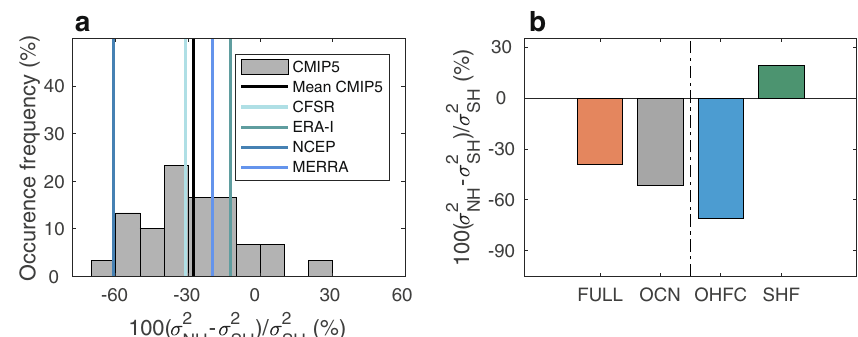
Fig. 1 Hemispheric difference in the Hadley cell variability and the role of ocean coupling. a The occurrence frequency (in percentage) of the difference in the variance of Ψ max in the NH ( σ 2 ) and SH ( σ 2 ) (in percentage) over the 1979 – 2017 period in CMIP5 models (gray bars). NH SH Black and blue vertical lines show the difference in the variance between the hemispheres in CMIP5 mean and reanalyses, respectively. b The difference in the variance of the NH and SH Ψ max in the FULL run (red bar). The relative contribution to the difference in the variance from ocean coupling (gray bar, OCN) and from decomposing the ocean coupling to dynamic coupling (OHFC, blue bar) and thermodynamic coupling (SHF, green to σ 2 . Almost all CMIP5 models (27 out of 30, gray bars in Fig. 1a) SH show that σ 2 is smaller than σ 2 , with a multi-model mean value NH SH of − 28% (vertical black line). Similarly, all reanalyses show that the Ψ max variability in the NH is smaller than the variability in the SH, with a mean value of − 31% (vertical blue lines in Fig. 1a); in CFSR,